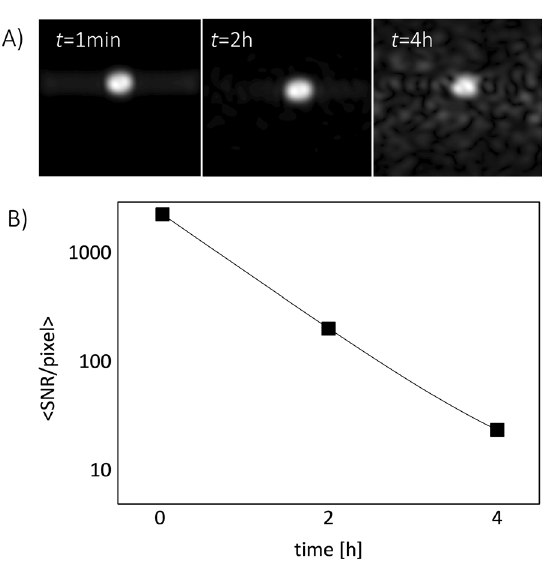
Figure 4. ( A ) Three consecutive images of a dry powder obtained after 1 min, 2 h and 4 h after the transfer to the imaging system. Each sample was polarized for 24 h before imaging. ( B ) Decay of average SNR/pixel with time after transferring the sample to the imaging